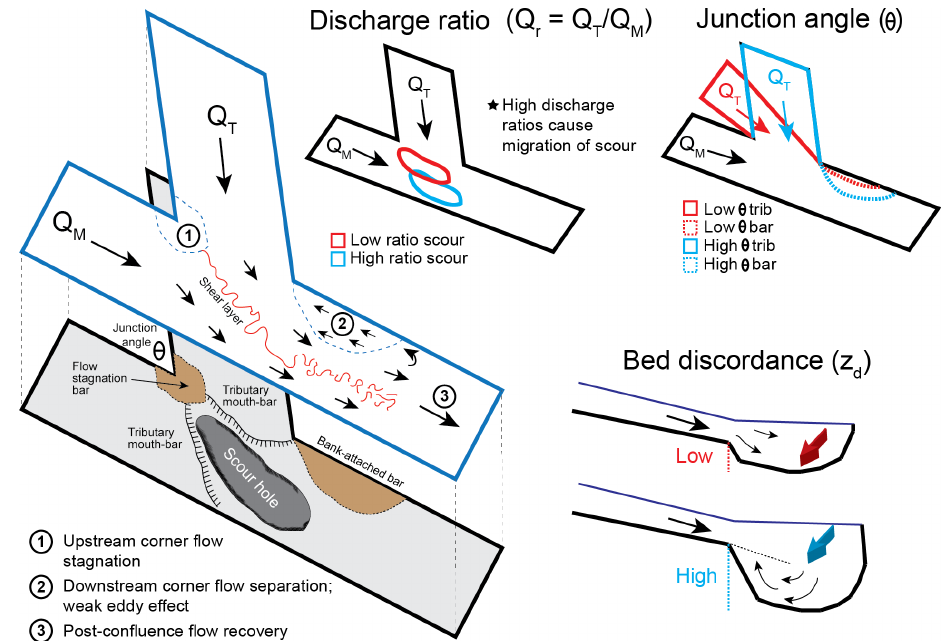
Figure 1. Flow (top left) and morphology (bottom left) in a gravel-bed confluence (after Best, 1987). Key variables influencing hydraulics and morphology include discharge ratio ( Q r ), junction angle ( θ ), bed discordance ( z d ), and upstream planform geometry (not